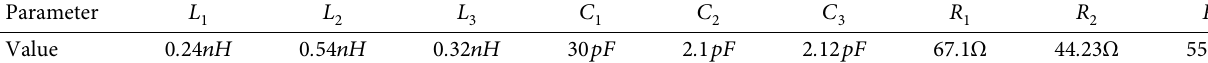
� 0 . 5and L � 0 . 73 nH ) . 0 0